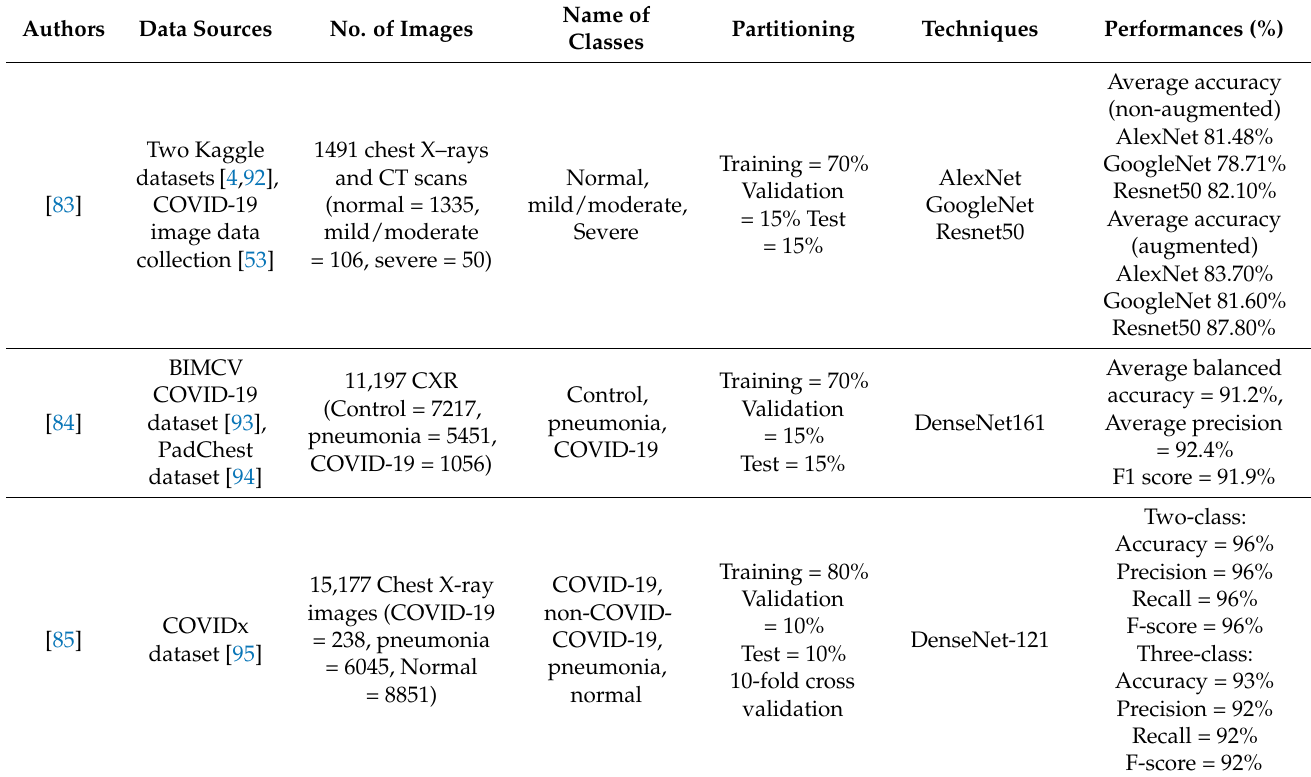
Table 7. Summary of deep learning based COVID-19 multi-classification using pre-trained model with deep transfer